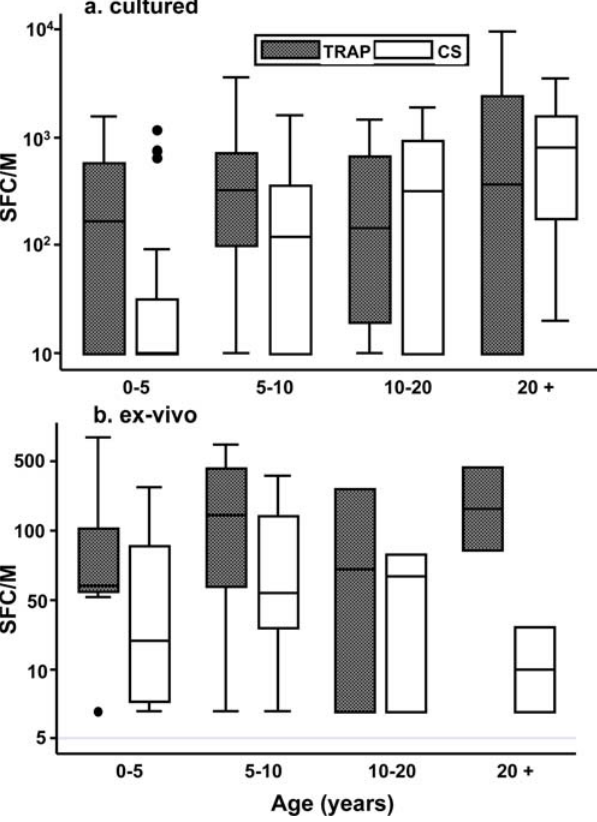
Figure 1. Relationship between ELISPOT responses and age. Cultured ELISPOT responses against (a) TRAP and (b) CS for individuals were stratified according to age into 4 groups: 0–5, 5–10, 10–20, and over 20. Median, 25 th and 75 th quartile, 5 th and 95 th quartile and outlying points are given by box and whisker plots.